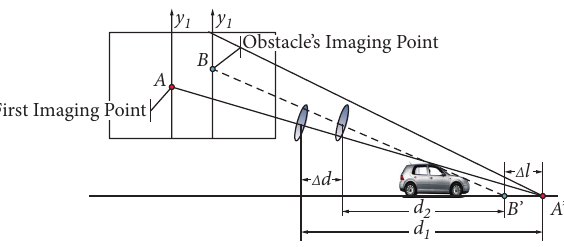
Figure 2: Schematic diagram of static obstacle